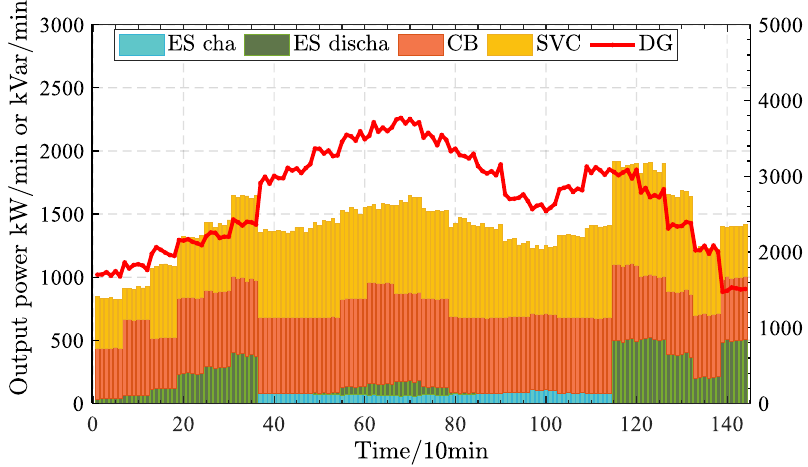
Figure 14. Intraday Scheduling Status.